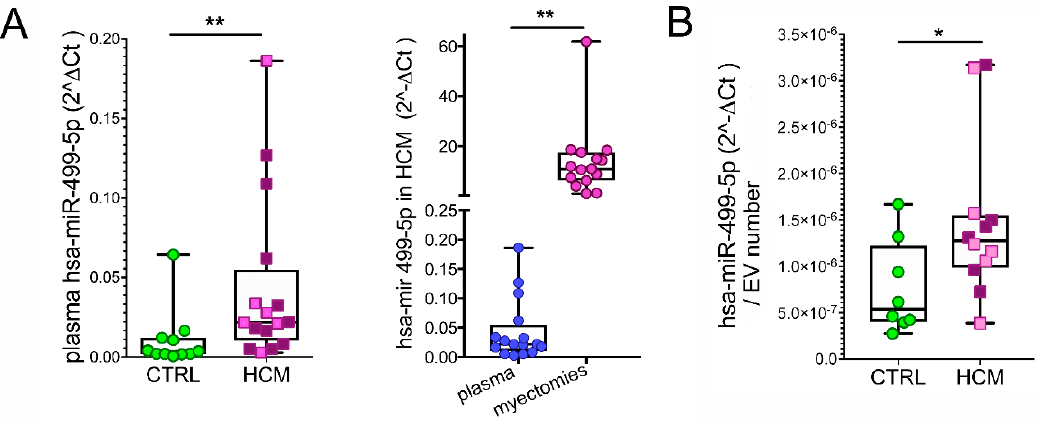
Figure 4. Circulating miR-499 . The difference between hsa-miR-499-5p levels in plasma samples from HCM (n = 16) and healthy volunteers (CTRL, n = 11) is shown (( A ) , left plot ). The comparison between expression levels of hsa-miR-499-5p in myocardial and plasmatic samples from the same HCM patients is presented (( A ) , right plot ). The difference between hsa-miR-499-5p levels in plasma EV from subsets of HCM (n = 12) vs. CTRL (n = 8) is plotted ( B ). Mann–Whitney test and paired and unpaired t -tests are applied, respectively. p -value < 0.05 is considered significant and indicated by *; p < 0.01 is indicated by **.